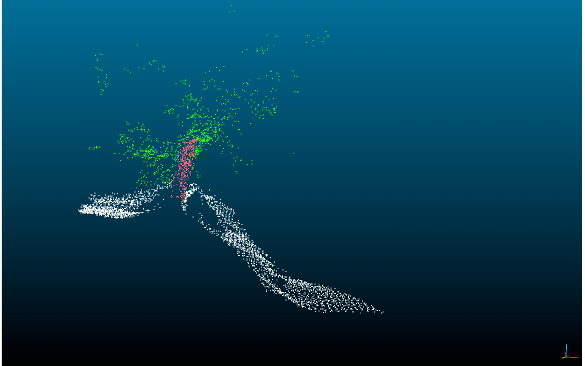
Figure 5. Final segmentation into terrain areas (white), standing remains (pink) and vegetation (green).